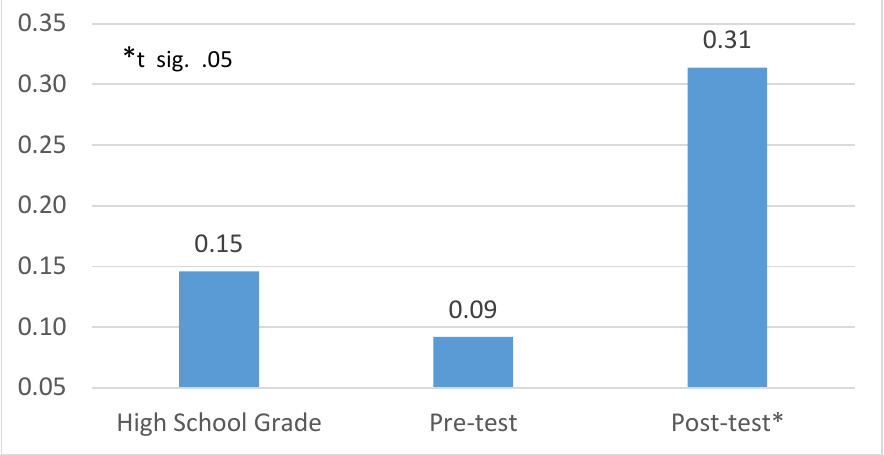
FIGURE 9. BETAS FOR REGRESSION OF COUSE GRADE FOR 1010 A AND B